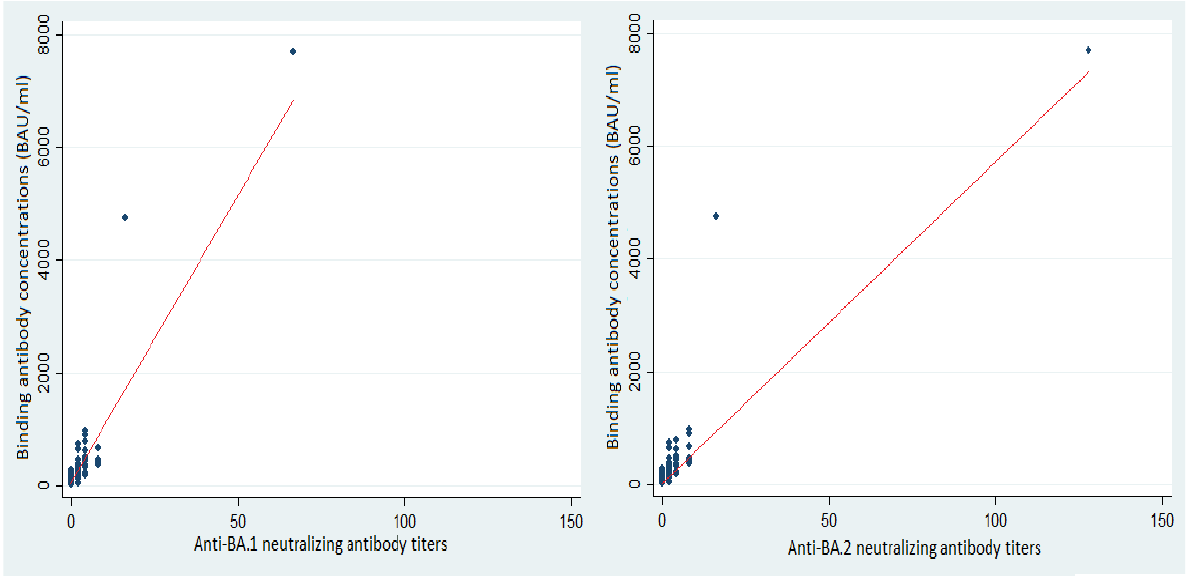
Figure 2. Binding antibody concentrations according to BA.1 and BA.2 neutralizing antibody titers among uninfected/vaccinated HCWs and trend curve (red line).